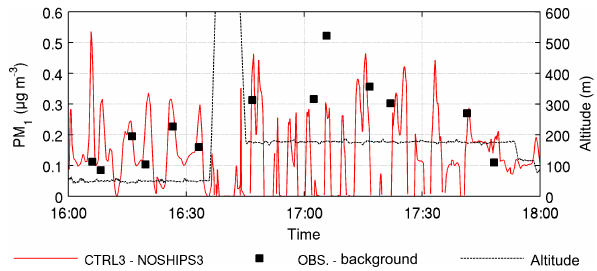
Figure 7. Observed background-corrected PM 1 enhancements in the plume of the Costa Deliziosa on 11 July 2012 (black squares), compared to modeled PM 1 enhancements in ship plumes (in red), extracted along the flight track (CTRL3 – NOSHIPS3 PM 1 ). A 56s averaging window is applied to the measured data to simulate dilu- tion in the model grid. Flight altitude is given as dashed black